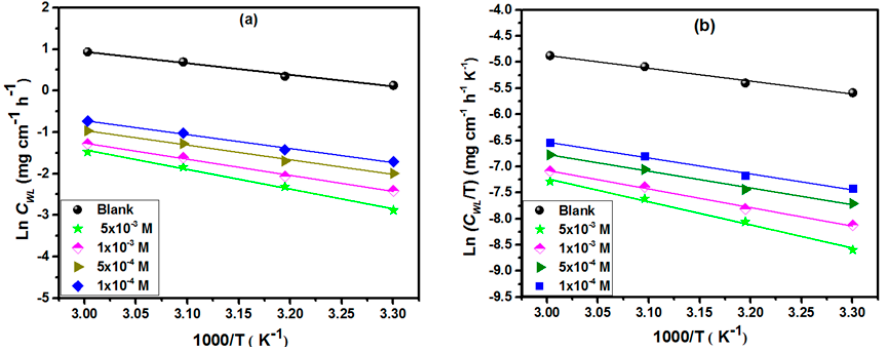
Figure 3. Arrhenius ( a ) and transition state ( b ) plots of the corrosion rate for mild steel dissolution in 1.0 M HCl solution in the absence and presence of different concentrations of HYD-1.